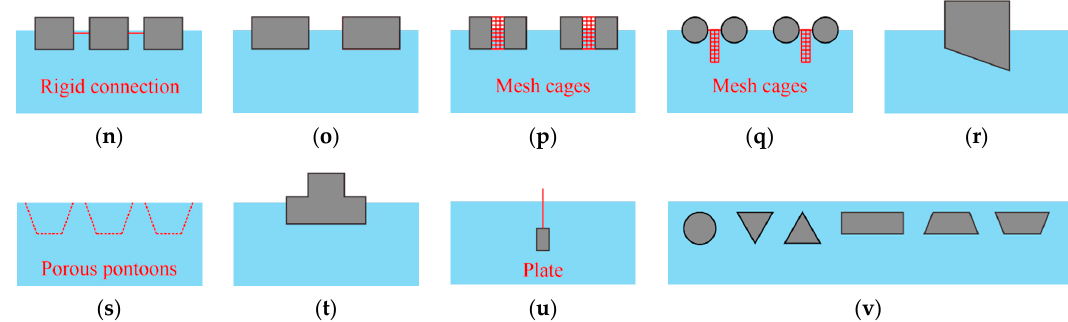
Figure 1. Different types of floating breakwaters: ( a ) Cuboid pontoon [2]; ( b ) Cylindrical pontoon [3]; ( c ) Π -type pontoon [4]; ( d ) Cuboid pontoon-plates [5]; (e) Pontoon with an air chamber [6]; ( f ) Pontoon with two air chambers [7]; ( g ) Permeable structure [8]; ( h ) Y-Type pontoon [9]; ( i ) Trapezoidal pontoon-porous plates [10]; ( j ) Horizontal plate-nets [11]; ( k ) Dual cuboid pontoon [12]; ( l ) Dual cylindrical pontoon [13]; ( m ) Dual cylindrical pontoon-nets [14]; ( n ) Triple cuboid pontoons [15]; ( o ) Double-row cuboid pontoons [16]; ( p ) Double-row cuboid pontoons-mesh cage [17]; ( q ) Double-row cylindrical pontoons-mesh cage [18]; ( r ) F-type pontoon [19]; ( s ) Trapezoidal porous pontoons [20]; ( t ) T-type pontoon [24]; ( u ) Curtain wall [69]; ( v ) Pontoon with different cross-sections [73].